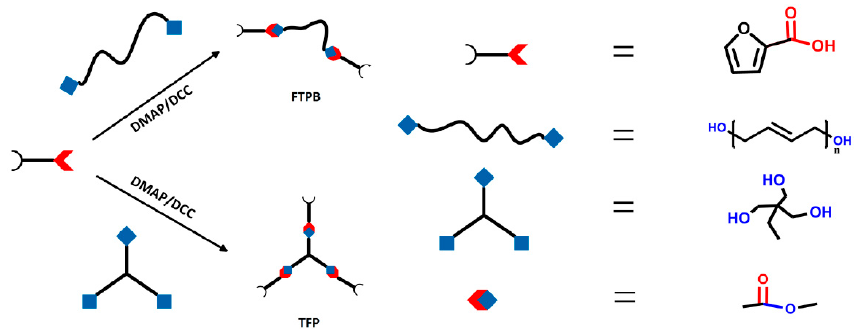
Figure 1. Synthesis routes of furfuryl-terminated polybutadiene (FTPB) and trifurfuryl propane (TFP).